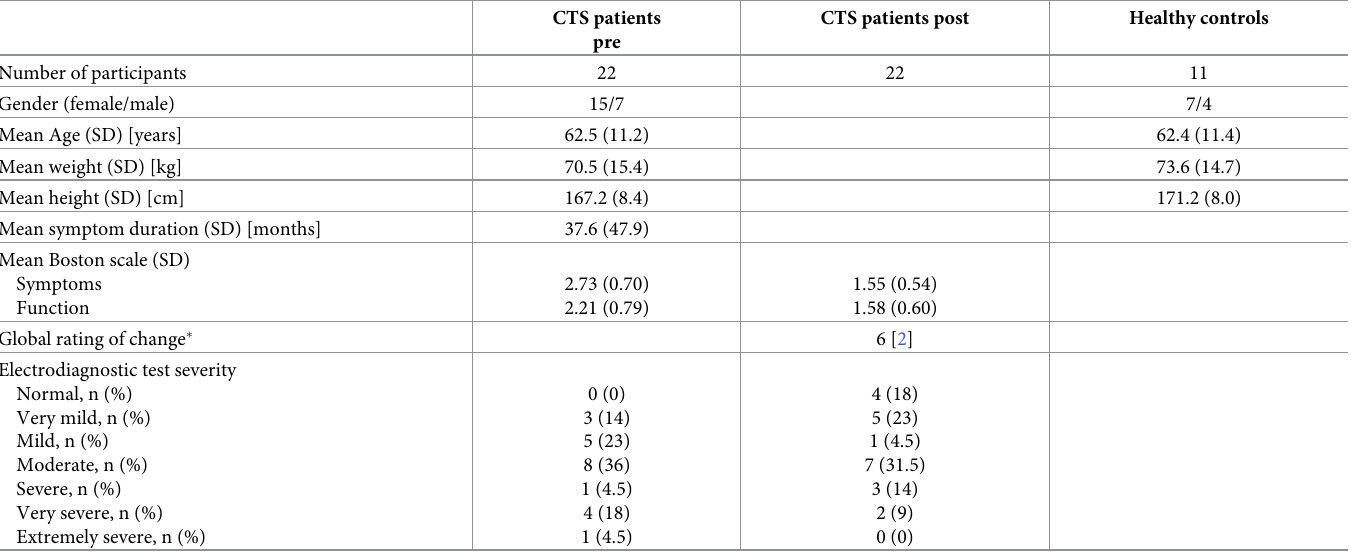
Table 1. Participant characteristics.